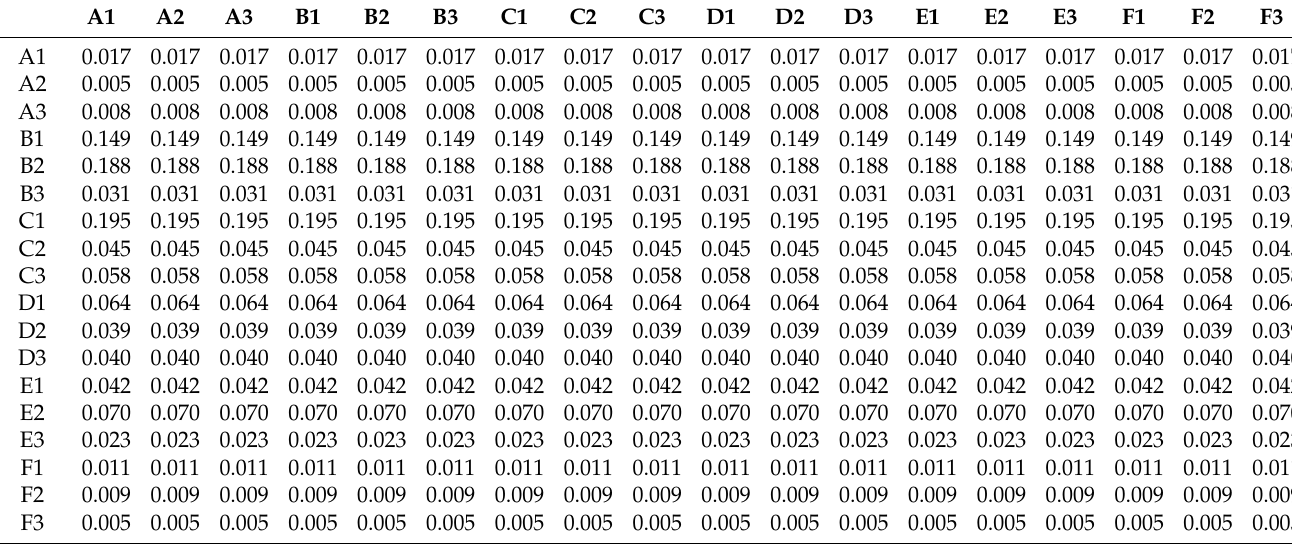
Table A4. The limiting